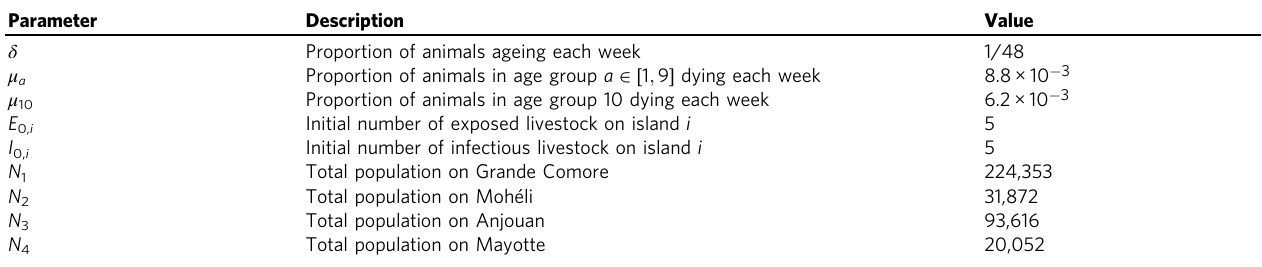
Table 1 Fixed model